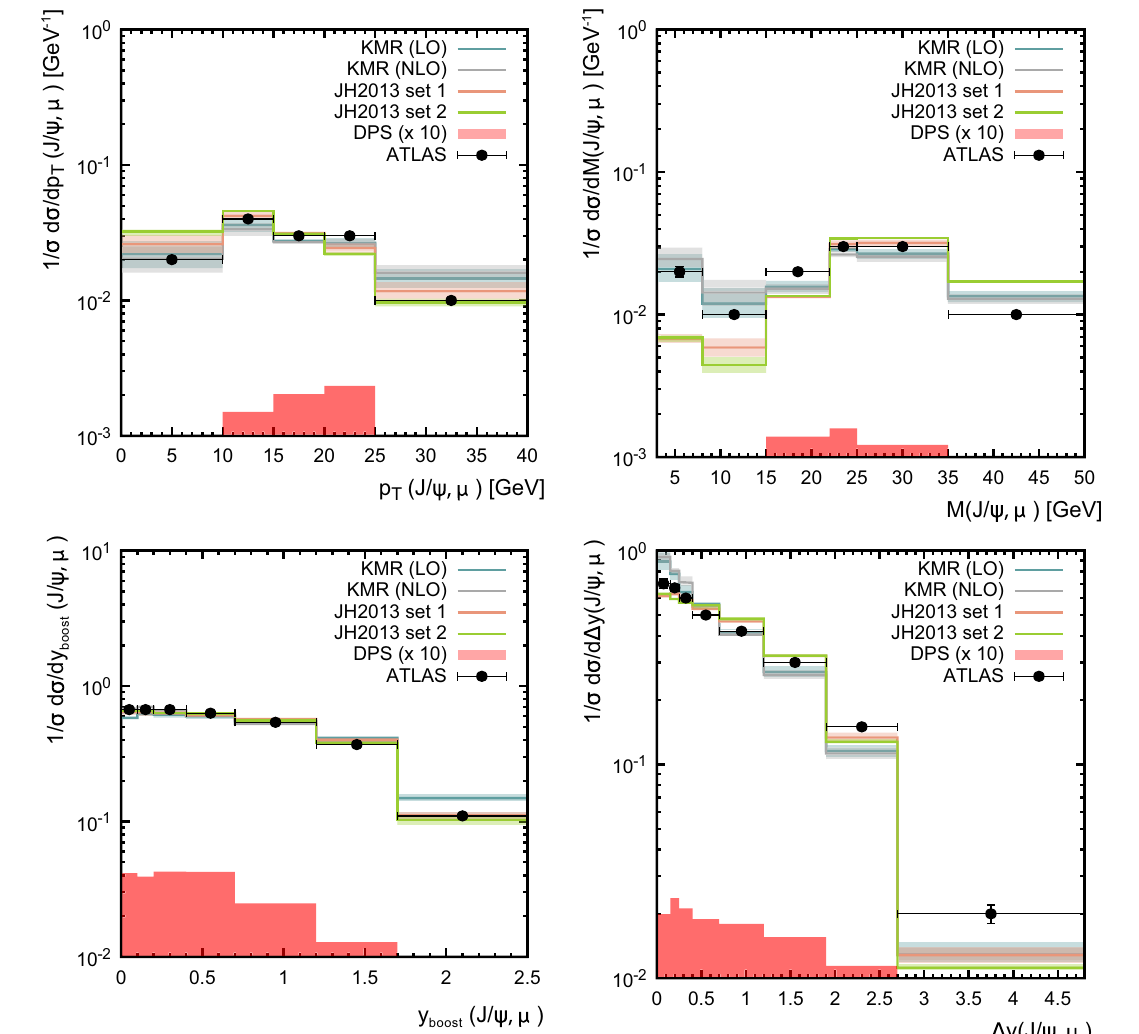
√ s = 8 TeV as a function of p T ( J /ψ,μ) ,